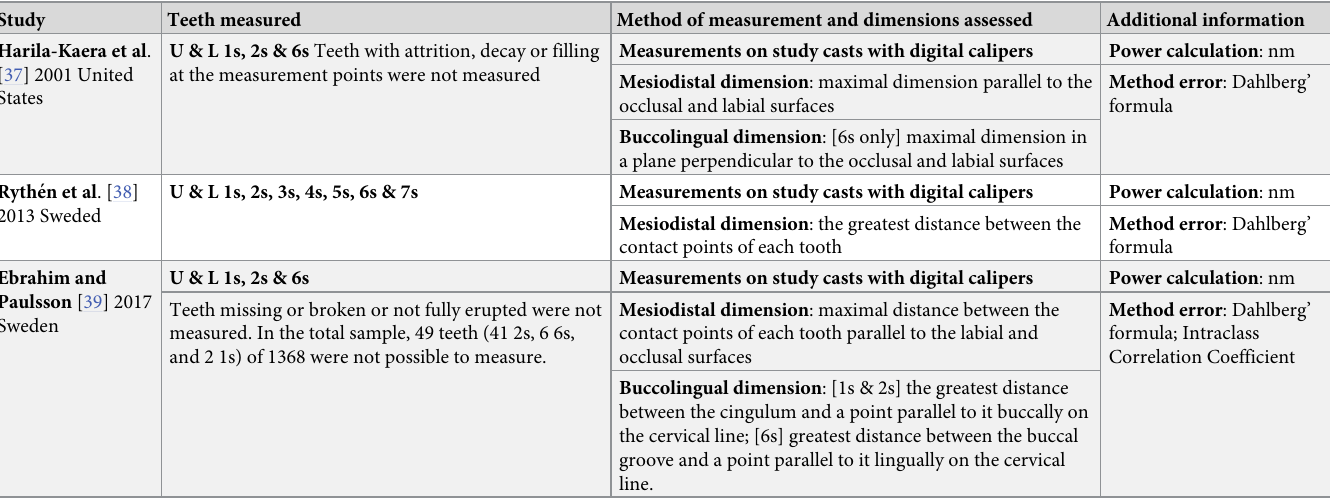
Table 2. Outcome measurement characteristics of the studies included in the systematic review.